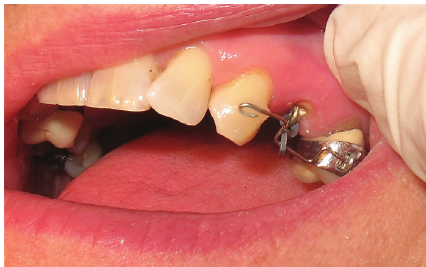
Figure 1: Fractured UL4 & porcelain crown on UL5.